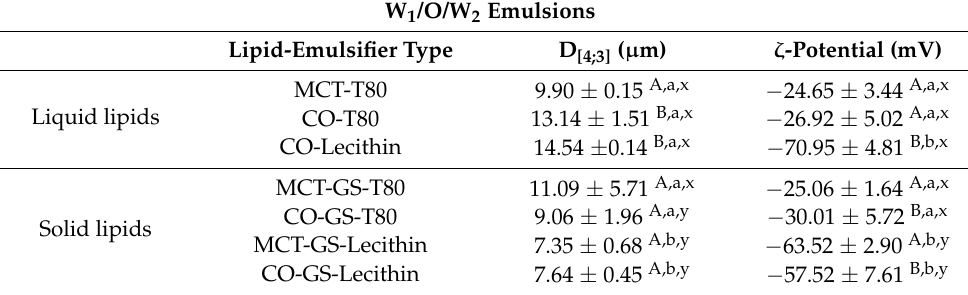
Table 4. Droplet size (D [4;3] ) and ζ -potential (mV) of chlorophyllin-loaded W 1 /O/W 2 emulsions formulated with different lipid phases consisting on medium chain triglyceride (MCT) or corn oil (CO) and without or with glyceryl stearate (GS) as well as different hydrophilic surfactants (Tween 80 (T80) or Lecithin). A, B indicates significant differences between the lipid type. a, b indicates significant differences between the used surfactants. x, y indicates significant differences between the lipid phase